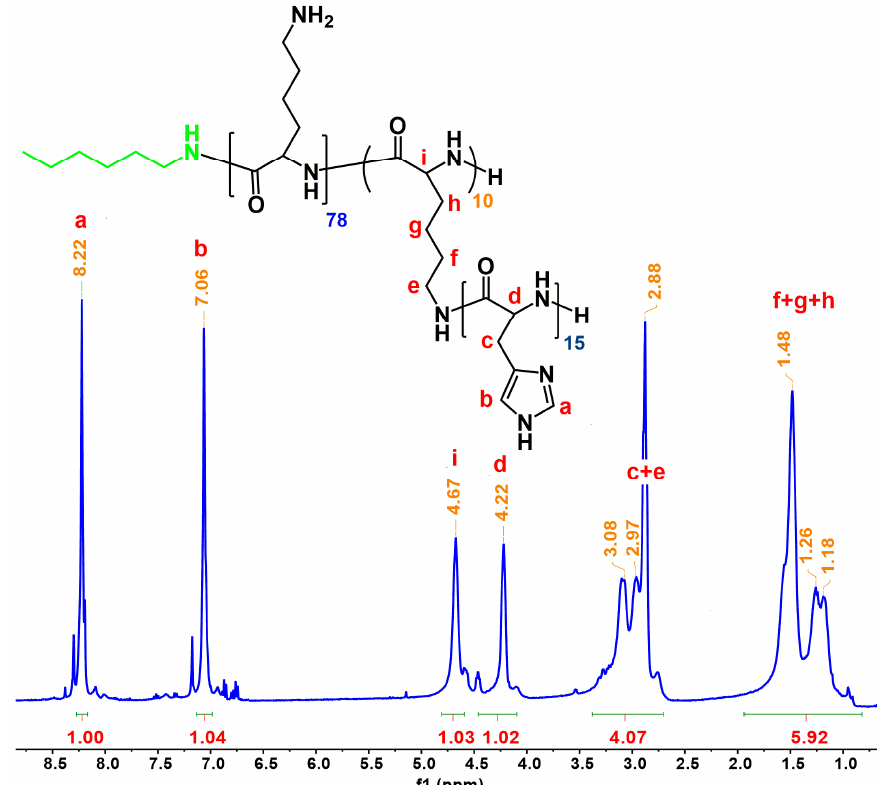
Figure 13. 1 H-NMR spectrum of the fully deprotected PLL 78 – b – (PLL 10 – g – PHIS 15 ) block – graft polymer.